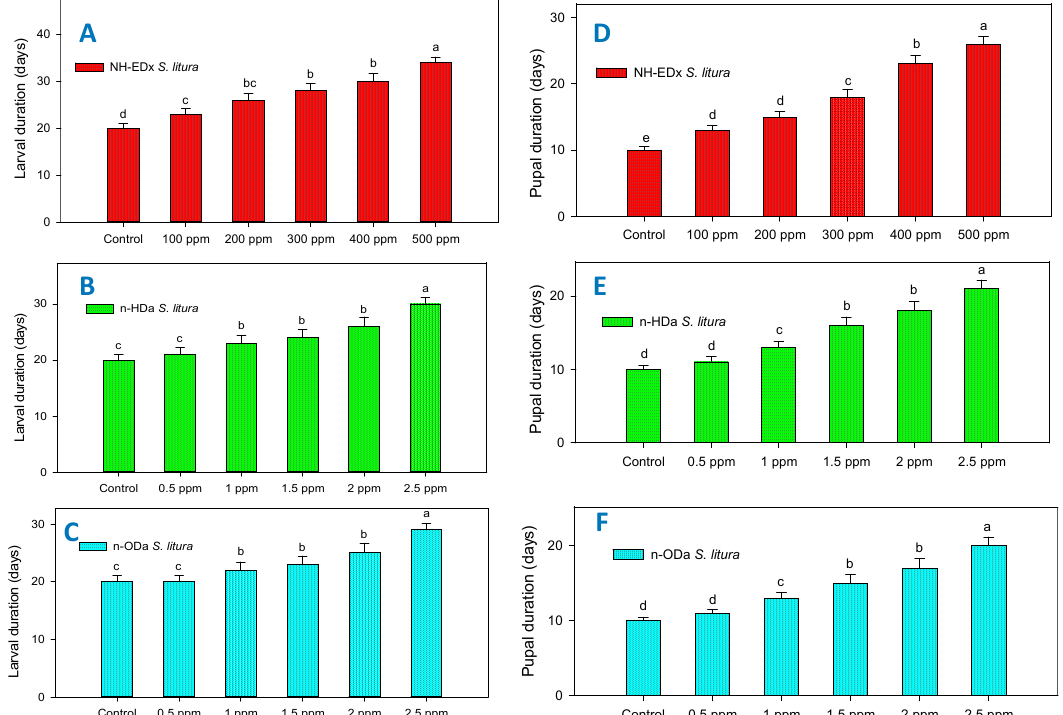
Figure 4. Developmental time in days for S. litura larvae after treatment with NH-EDx ( A ), n -HDa ( B ), and n -ODa ( C ), and for S. litura pupae after treatment with NH-EDX ( D ), n -HDa ( E ), and n -ODa ( F ), respectively. Means ( ± SEM) followed by the same letters above bars indicate no significant difference ( p ≤ 0.05) according to a Tukey’s test.